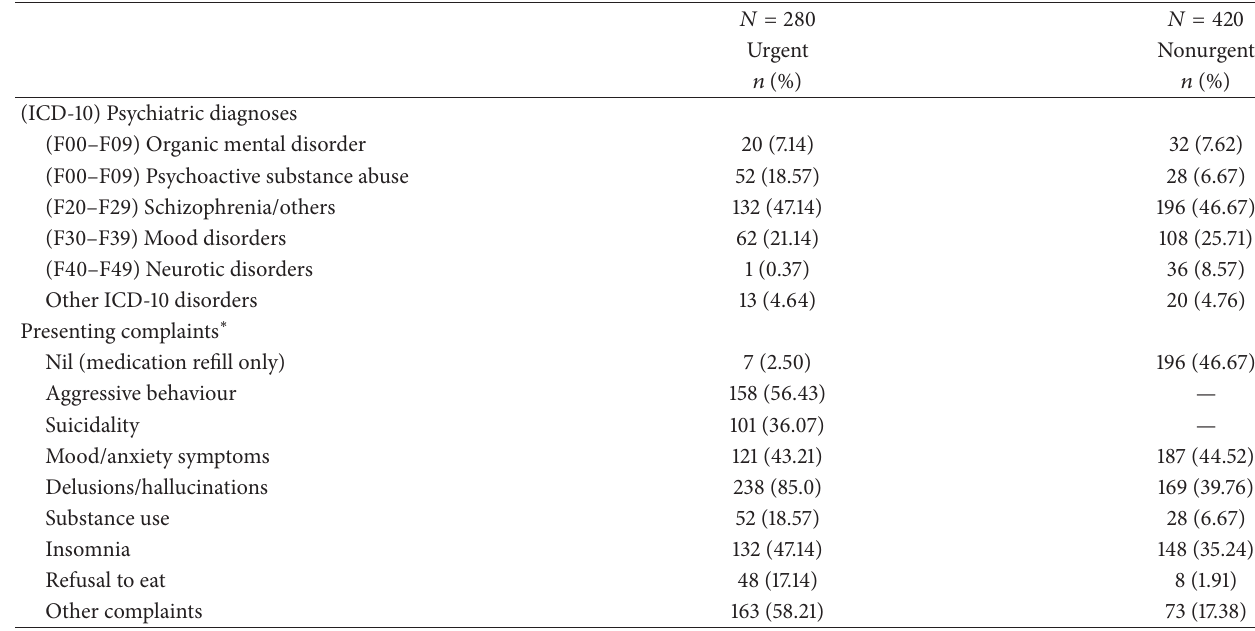
Table 3: Distribution of diagnosis and presenting